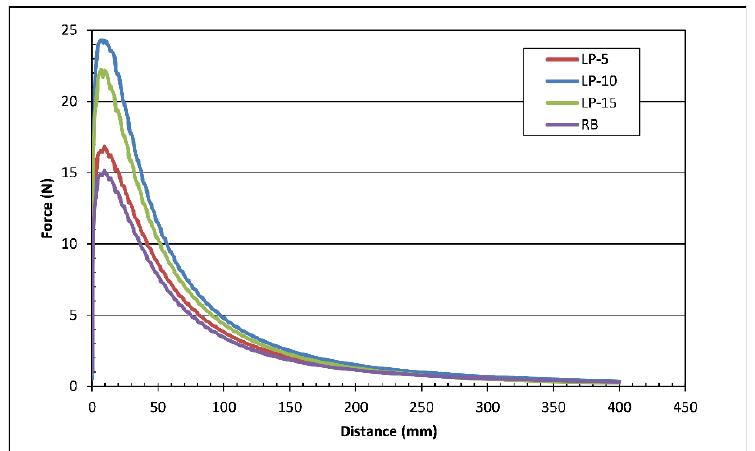
Figure 14. Force vs. distance plot results of force ductility test.